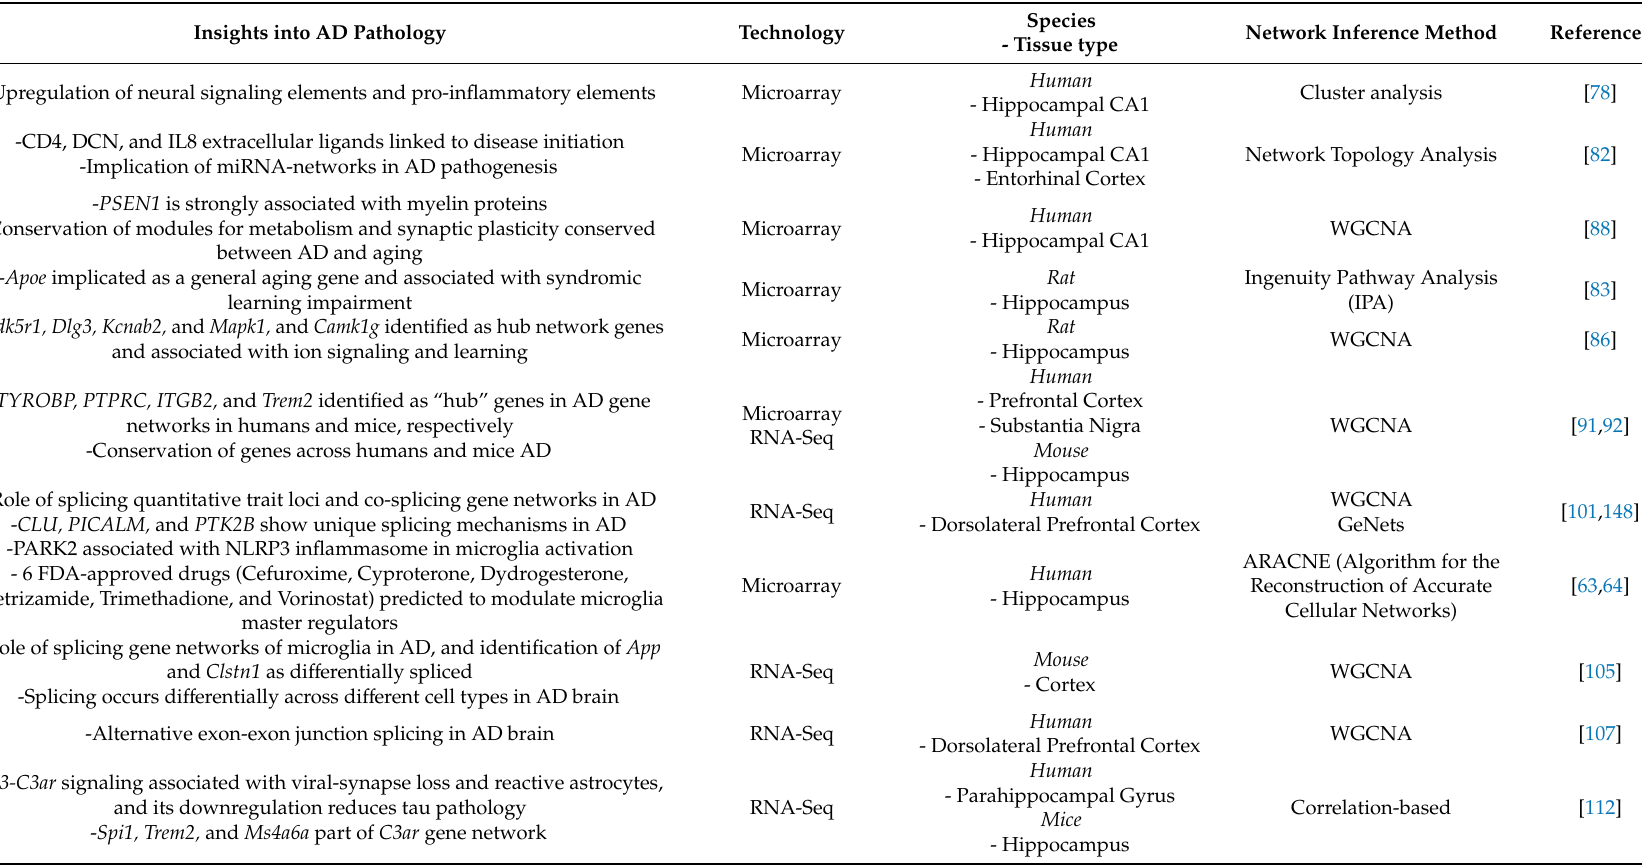
Table 1. Overview of the relevant biological insights into Alzheimer’s disease (AD) pathology obtained by transcriptional gene network analysis, which was performed using di ff erent transcriptomic technologies, species, tissue types and network inference